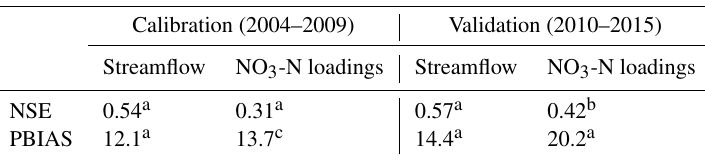
-N loadings during the calibration (2004–2009) and validation period 3